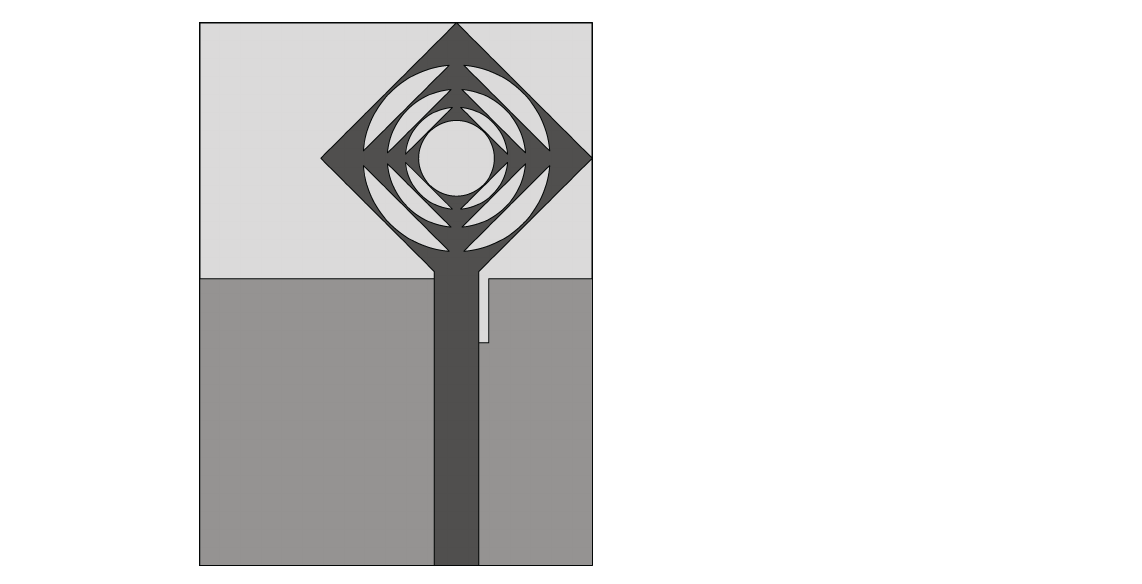
Figure 17. Geometry of a planar fractal antenna for UWB imaging applications (redrawn from [76]). Dark gray top metal face, medium gray bottom metal face, and light gray dielectric substrate.